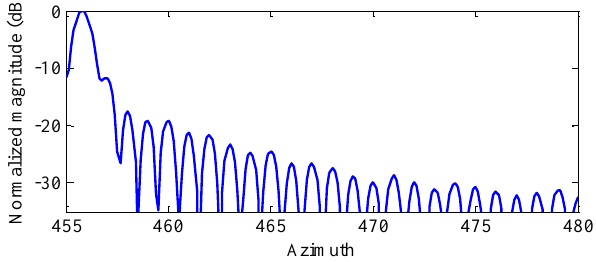
Figure 13. Normalized azimuth profile corresponds to the green line in Figure 10b. Note that only part of the profile is shown for a clear